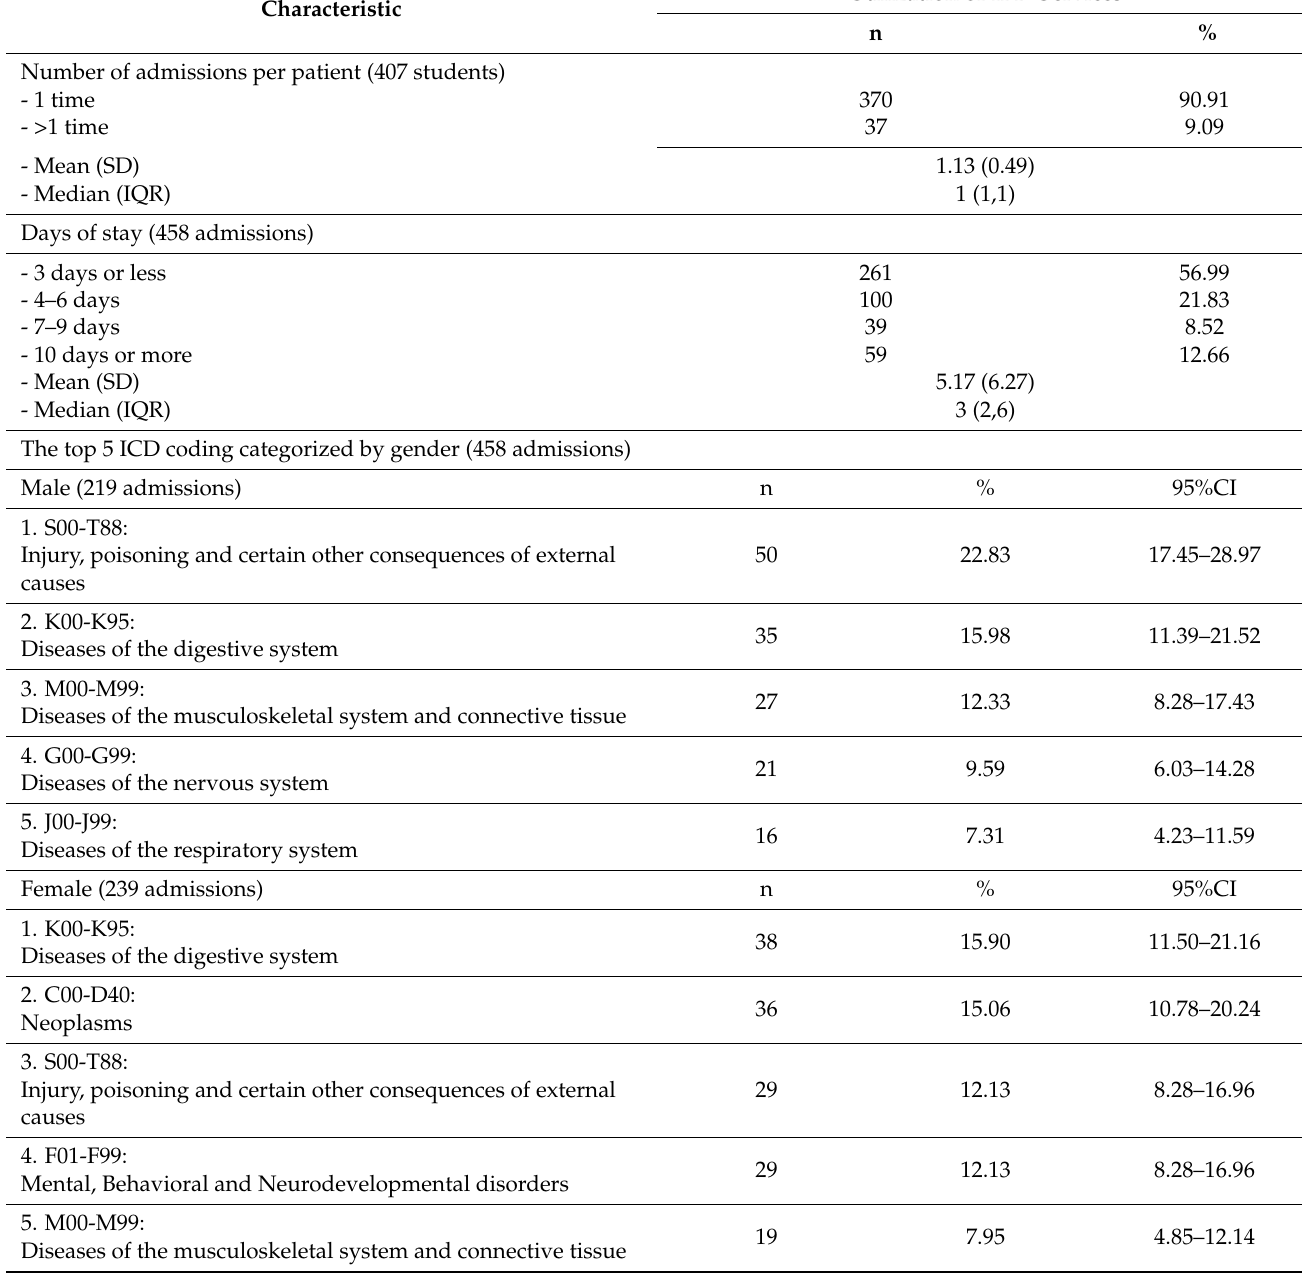
Table 5. The characteristics of utilization of IPD services (407 students with 458